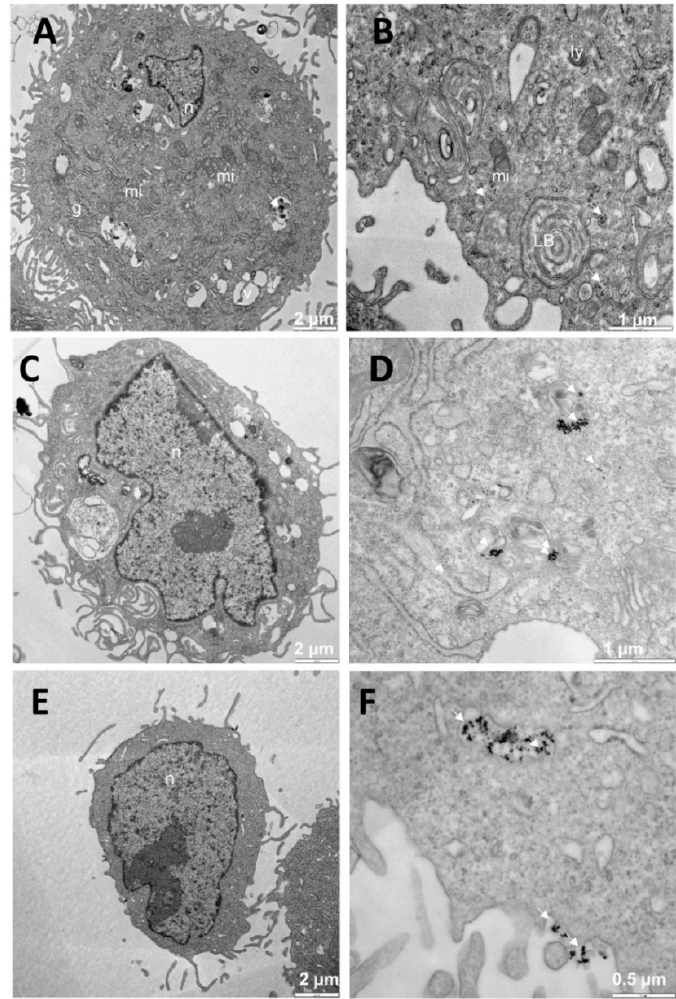
Figure 7. TEM images of A549 cells treated with Au@16-pH-16/N 1 ( A , B ), N 2 ( C , D ), and N 3 ( E , F ). The dense bodies indicated by an arrow were compatible with the gold core of the nanoparticles.